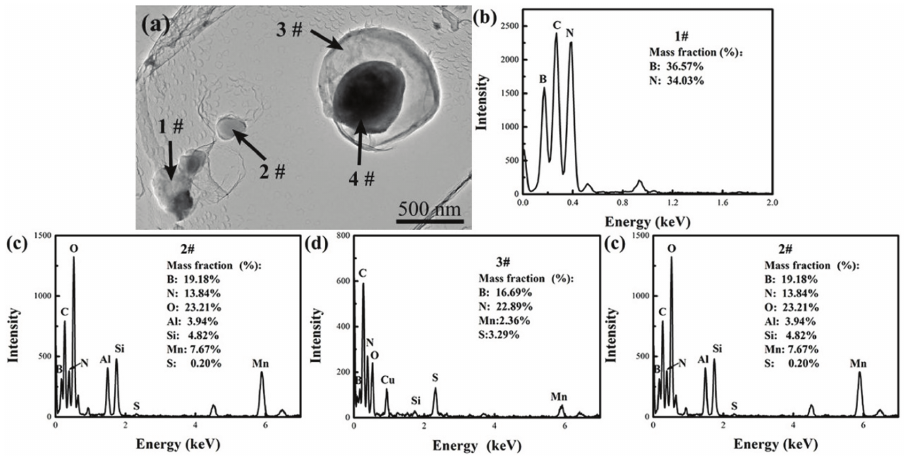
Figure 6: The typical secondary phase particles in alloy B1: (a) The morphology of the secondary phase particles; (b – e) The EDS spectrums of the secondary phase particles denoted by 1 – 4# in image (a),